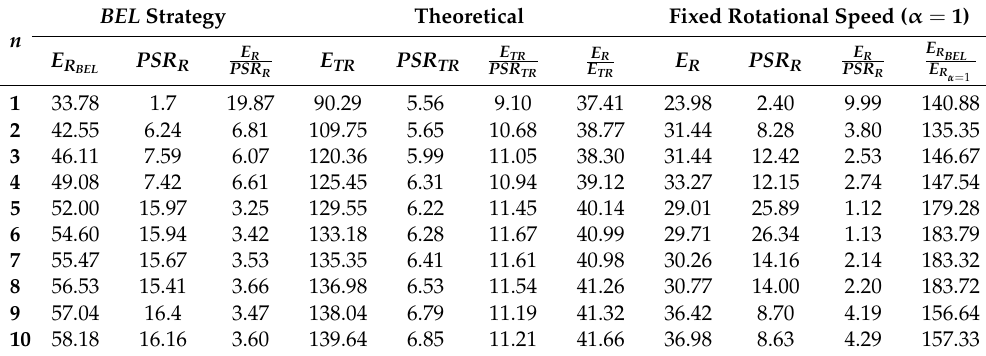
Table 4. Comparison between recovered energy for the maximization of the recovered energy ( E R